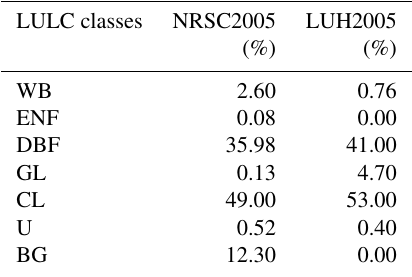
Table 2. Percent of each land use type in NRSC2005 and LUH2005 in the entire Mahanadi river basin (WB – Water Body; ENF – Ever- green Needleleaf Forest; DBF – Deciduous Broadleaf Forest; GL – Grassland; CL – Cropland; U – Urban; BG – Barren